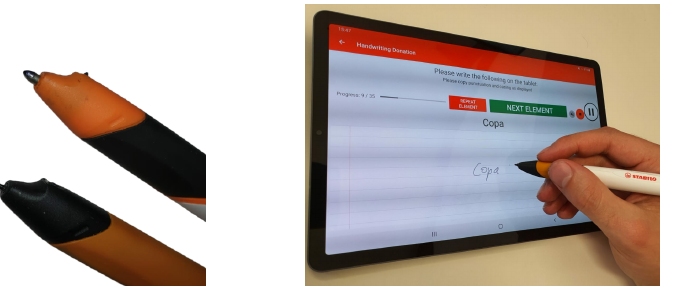
Figure 3. Wacom compatible writing tip on the Digipen ( left bottom pen ), and the recording app ( right